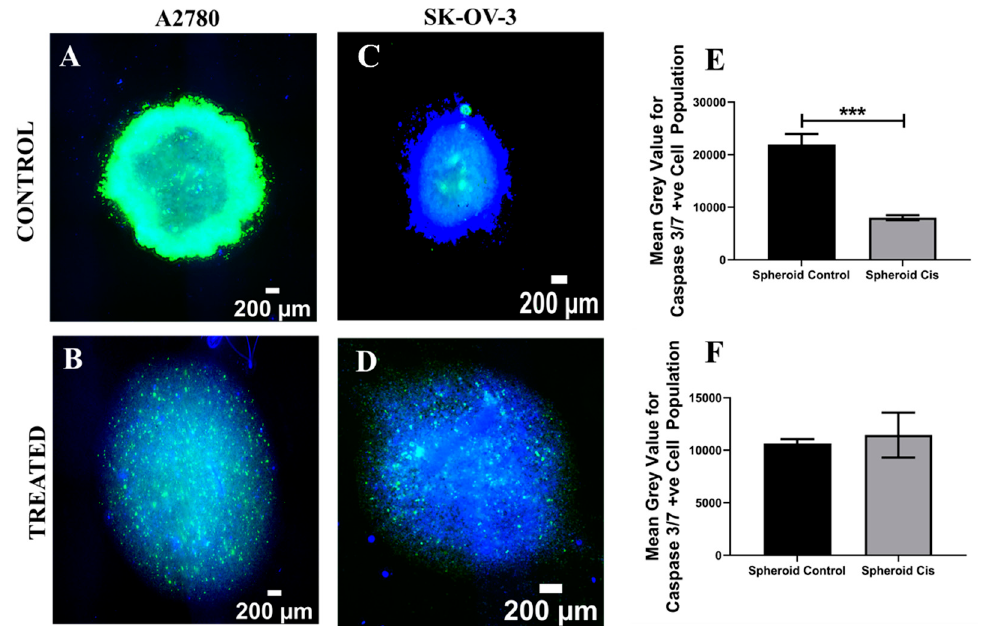
Figure 2 . Effect of the chemotherapeutic Cisplatin on the apoptosis of EOC spheroids 24 h post- treatment ( A – D ): Representative images for caspase 3/7 (apoptosis)–DAPI (green–blue) staining for untreated (control) and Cisplatin-treated A2780 and SK-OV-3 spheroids. ( E ) Image analysis-based quantification of apoptotic (green) image areas for A2780-treated and untreated spheroids. ( F ) Image analysis-based quantification of apoptotic (green) image areas for SK-OV-3-treated and untreated spheroids. Scale bar = 200 μ m. Quantitative data represent mean ± SEM for multiple images ( ≥ 3) and multiple spheroids ( ≥ 3). *** p ≤ 0.001 .